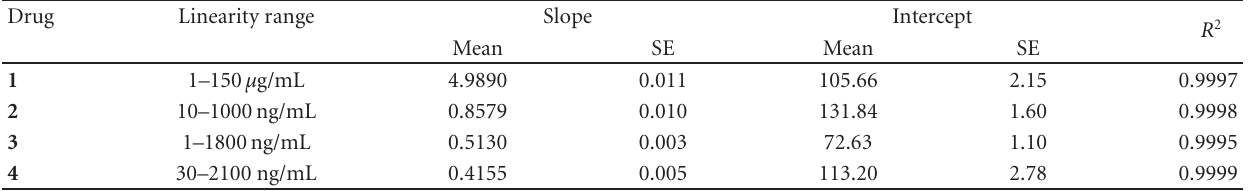
Table 2: Regression analysis parameters for the determination of 1–4 in standard solutions using the proposed method.